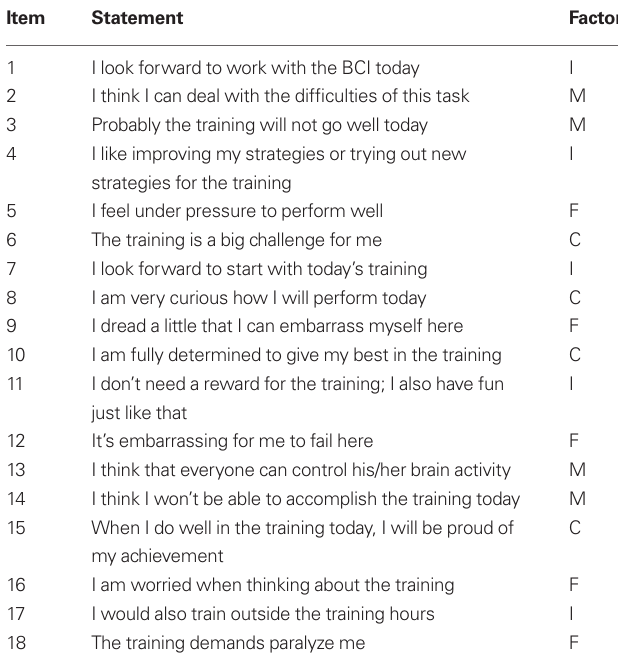
Table 2 | All items of the adapted QCM are translated from German to illustrate the nature of the questionnaire (English version not